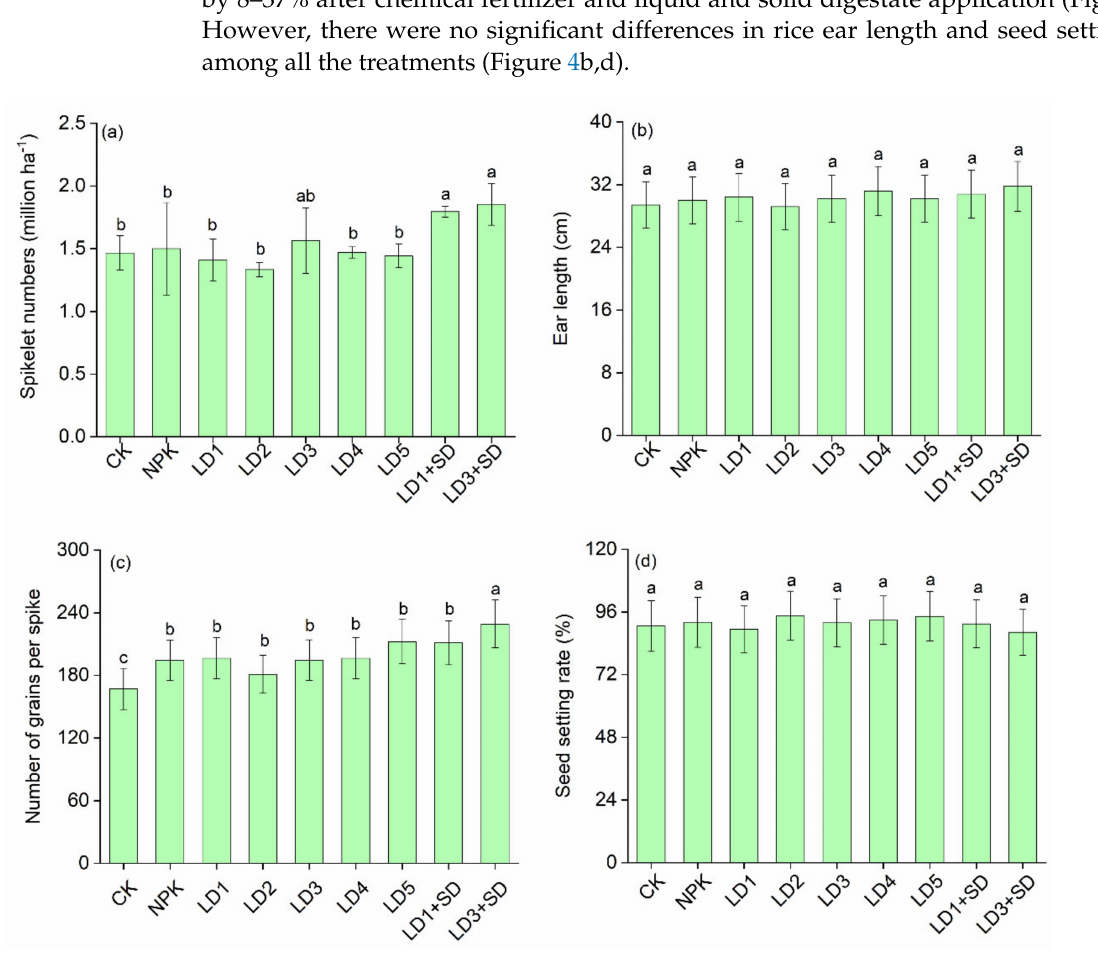
Figure 4. Rice spikelet numbers ( a ), ear length ( b ), numbers of grains per spike ( c ), and seed setting rate ( d ) under different treatments, respectively. The values are means with standard error bars. Different letters above the bars indicate significant differences at the 5%